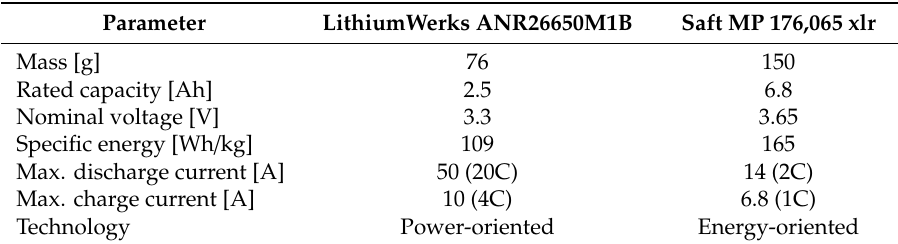
Table 1. Li-ion cell features.